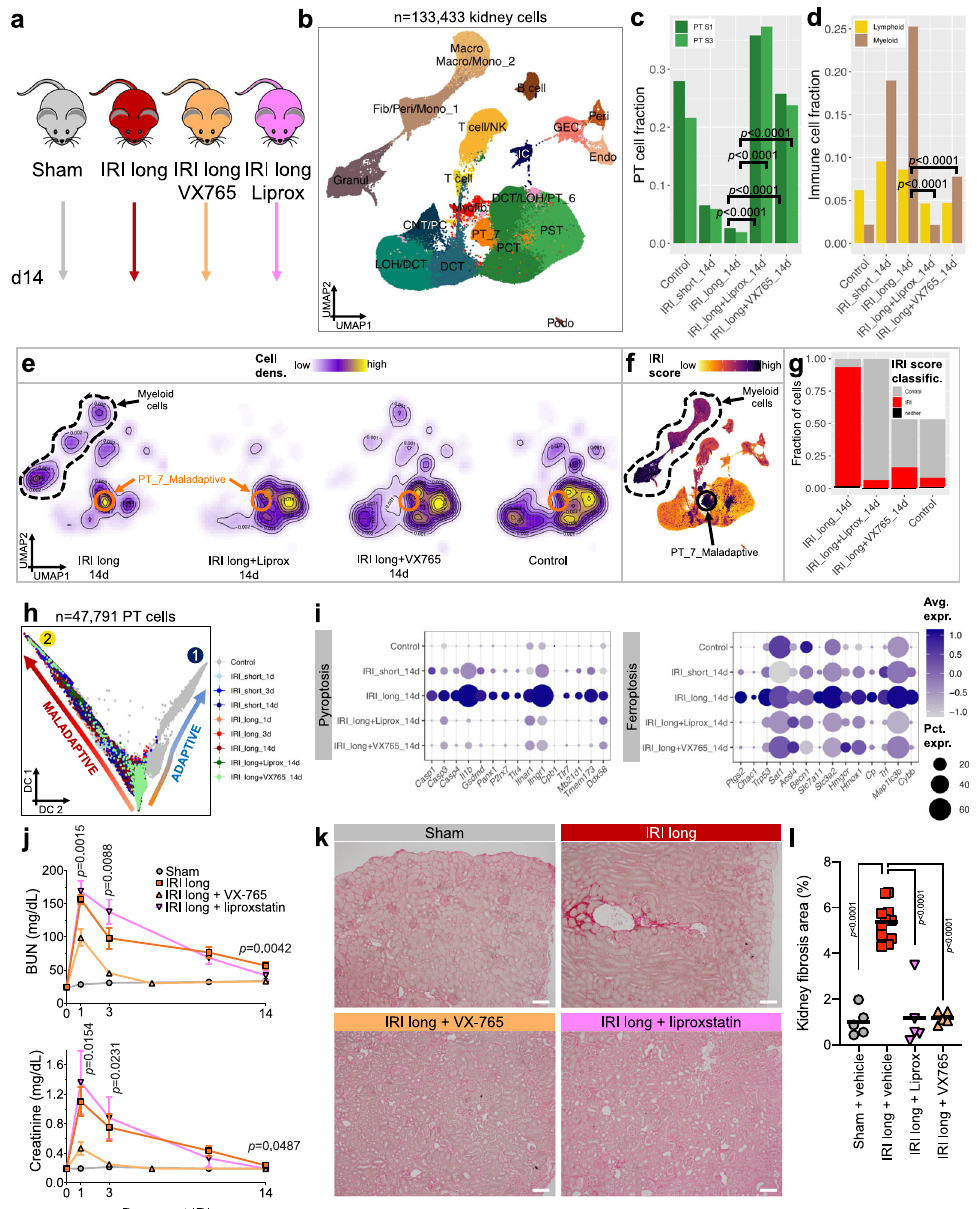
Fig. 9 Pharmacological inhibition of pyroptosis and ferroptosis ameliorates maladaptive kidney response and fi brosis after severe IRI. a Experimental setup. Male C57BL/6 mice were treated 30min before and daily after long (30min) bilateral renal ischemia with vehicle (IRI long), VX-765 (pyroptosis inhibition), or Liproxstatin (ferroptosis inhibition) for 14 d. Sham-operated animal served as controls; artwork own production and from https://smart.servier. com, license https://creativecommons.org/licenses/by-sa/3.0/). b UMAP projection of 133,433 cells of n = 6 controls, n = 6 IRI short, n = 6 IRI long, n = 1 IRI long + VX765, and n = 1 IRI long + Liprox samples passing rigid quality control fi ltering (nFeatures > 200 and < 3000, mt%< 50, doublet removal) and after dataset integration with LIGER. c , d Fractions of PT ( c ) and immune cell ( d ) clusters strati fi ed by treatment. Statistical signi fi cance for comparisons was derived using differential proportion analysis, with a mean error of 0.1 over 100,000 iterations; p values are given for comparisons between inhibitor and vehicle-treated IRI long groups. e Highest cell densities in IRI long samples were among PT_7_Maladaptive and myeloid clusters, whereas inhibitor-treated and control samples showed highest cell densities in healthy PT clusters. f IRI scores were highest in myeloid and PT_7_Maladaptive clusters. g Fractions of IRI-classi fi ed cells were drastically reduced in inhibitor-treated and control samples. h Diffusion map dimensional reduction of Slingshot-derived cell trajectories of 47,791 PT cells using Gaussian mixture modeling (GMM) yielded 9 clusters in 2 trajectories. Trajectory 1 encompassed mostly IRI short and control samples, trajectory 2 encompassed long IRI samples. Inhibitor-treated samples were right at the junction between lineages 1 and 2. i Dot plots showing experimental group-speci fi c expression of genes in PT cells involved in regulated cell death pathways pyroptosis and ferroptosis. Dot size denotes percentage of cells expressing the marker. Color scale represents average gene expression values. j Functional effects of pyroptosis and ferroptosis inhibition on long IRI. Blood urea nitrogen (BUN) and creatinine changes (right panel) 1, 3, and 14 d post-IRI; means ±SEM; p values are given for multiple t tests (Benjamini, Krieger, Yekuteli corrected) comparing IRI + VX-765 ( n = 5) vs. IRI + vehicle ( n = 11). IRI + Liprox ( n = 5) vs. IRI + vehicle ( n = 11) comparisons were non-signi fi cant; n = 3 independent experiments, n = 5 Sham samples. k Representative light microscopy of Sirius red-stained kidneys; scale bars = 50 µ m. l Fibrosis quanti fi cation from ( k ); p values are given for one-way ANOVA (Holm – Sidak